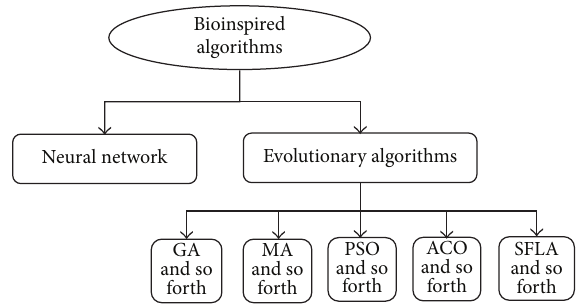
Figure 6: Elements of bioinspired